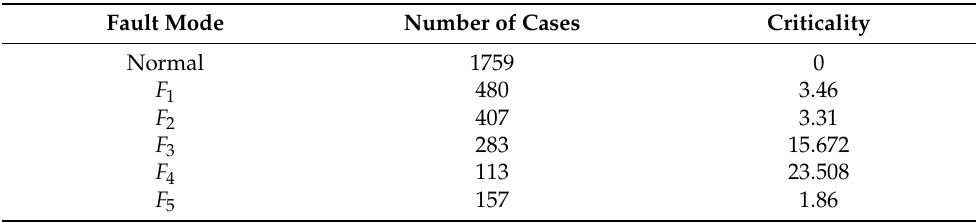
Table 2. The distribution and criticality of the different states of the KPG component.